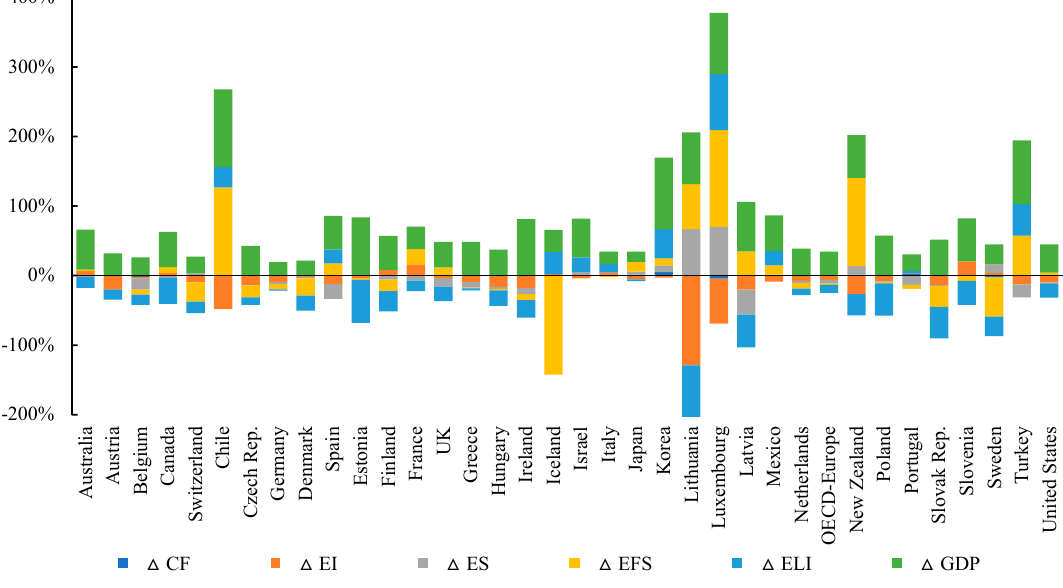
Figure 4. Decomposition results of CO 2 emission in power sector by driving factors, 1995-2008. 247